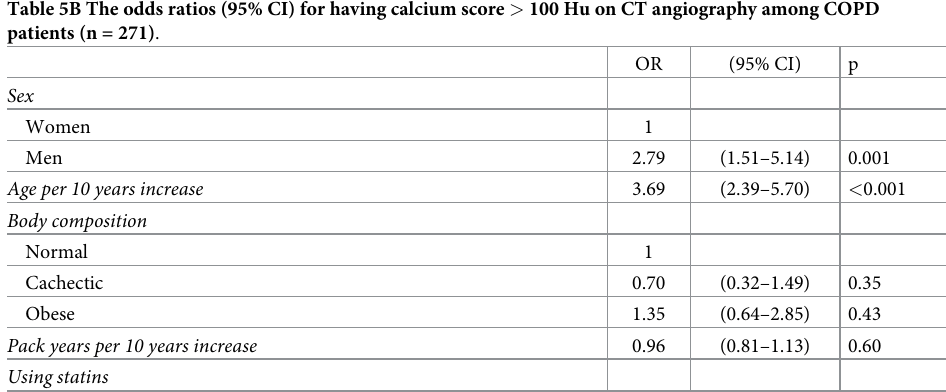
Table 5B The odds ratios (95% CI) for having calcium score > 100 Hu on CT angiography among COPD patients (n = 271)